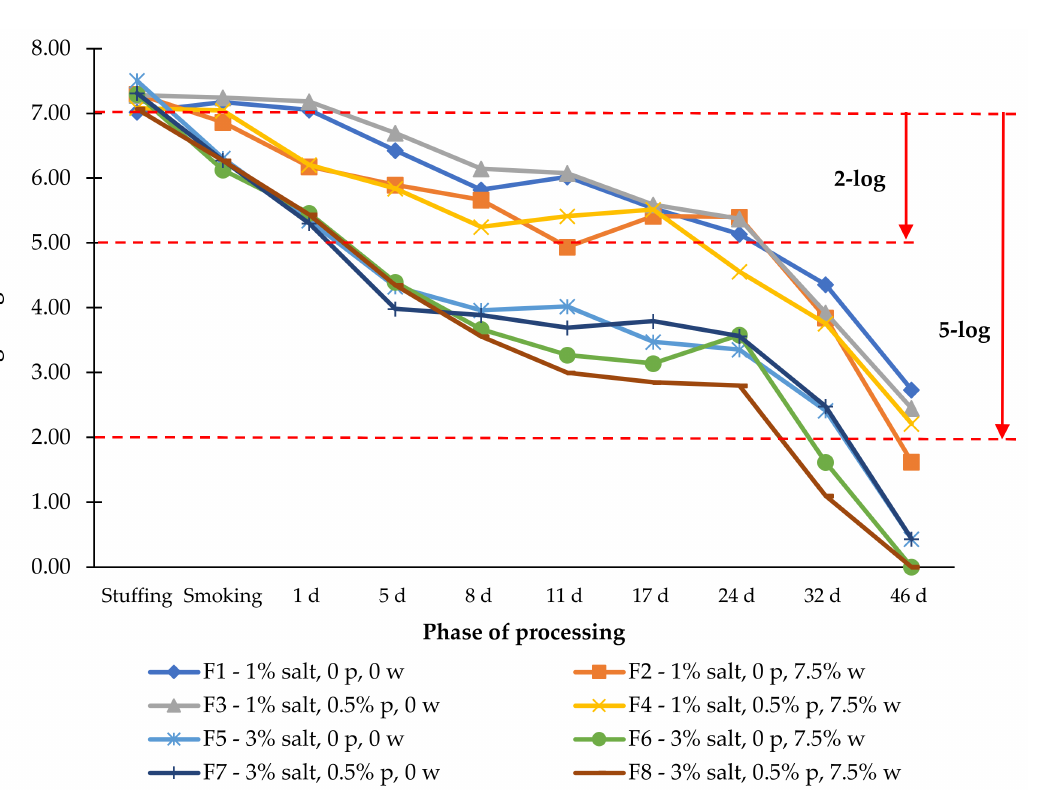
Figure 5. Survival of Salmonella during the processing of a cured sausage with the eight formulations tested ( n = 3). p—phosphate;